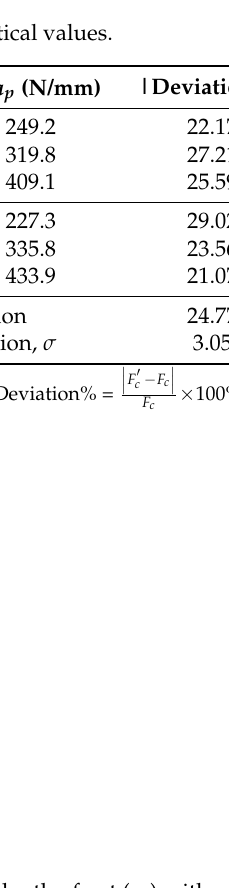
Figure 19. The variation of the ratio of the cutting force ( F c ) to the depth of cut ( a p ) with respect to the feed rate ( f ).